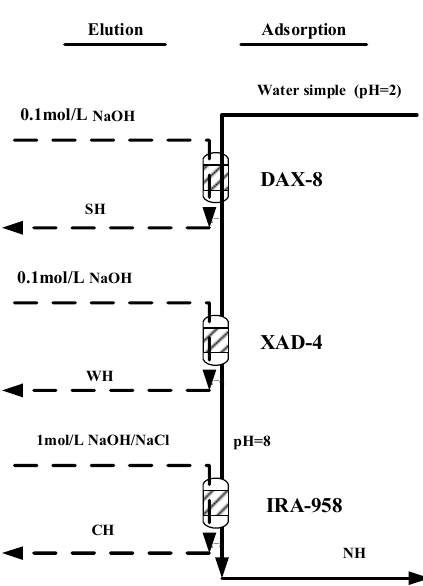
Figure 2. Outline of the water sample hydrophobicity fractionation procedure.